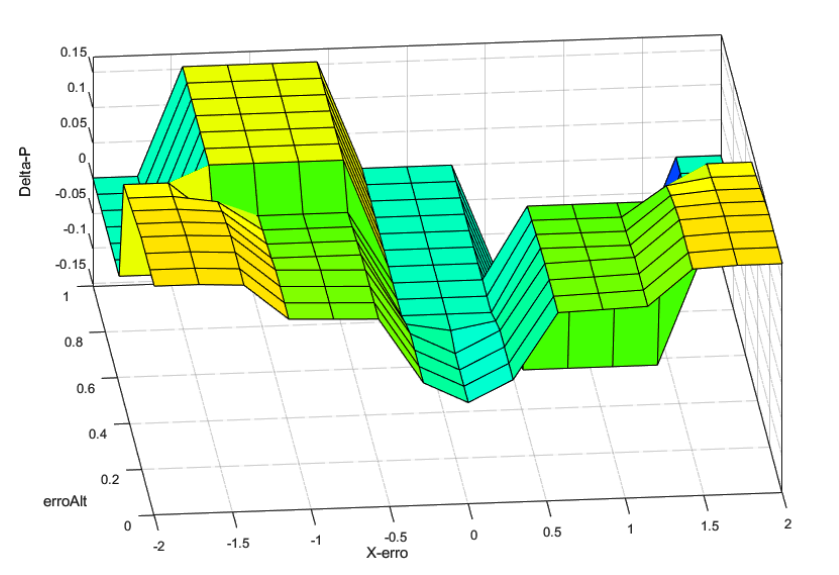
Figure 11. Fuzzy surface for position control-proportional gain.